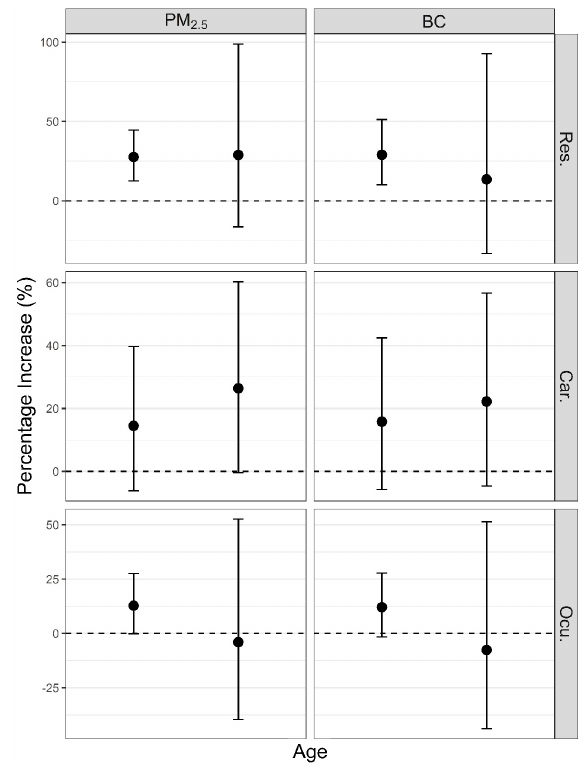
Figure 4. Estimated percentage increase in hospital ERVs (95% CI) for an IQR increase in PM 2.5 and BC in different age